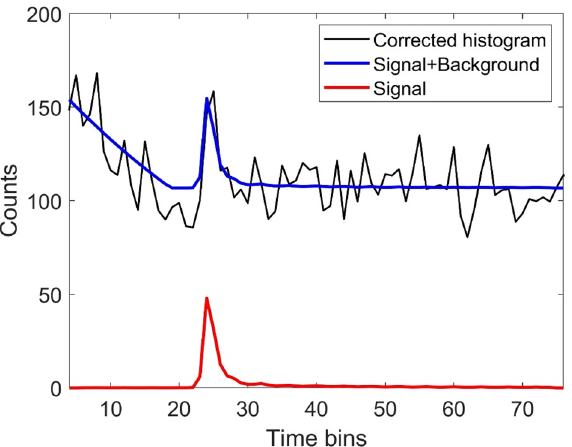
Figure 3. An example of a timing histogram from an individual pixel taken from a flat area of the 3D depth chart at 50 m range through 4.5 attenuation lengths of obscurant, showing the observed histogram after correction as discussed in the main text (black line), the estimated signal plus background (blue), and the estimated target signal (red). This histogram contains 80 timing bins due to the use of a 20 ns gate duration by the detector. Further details in main text and Fig.